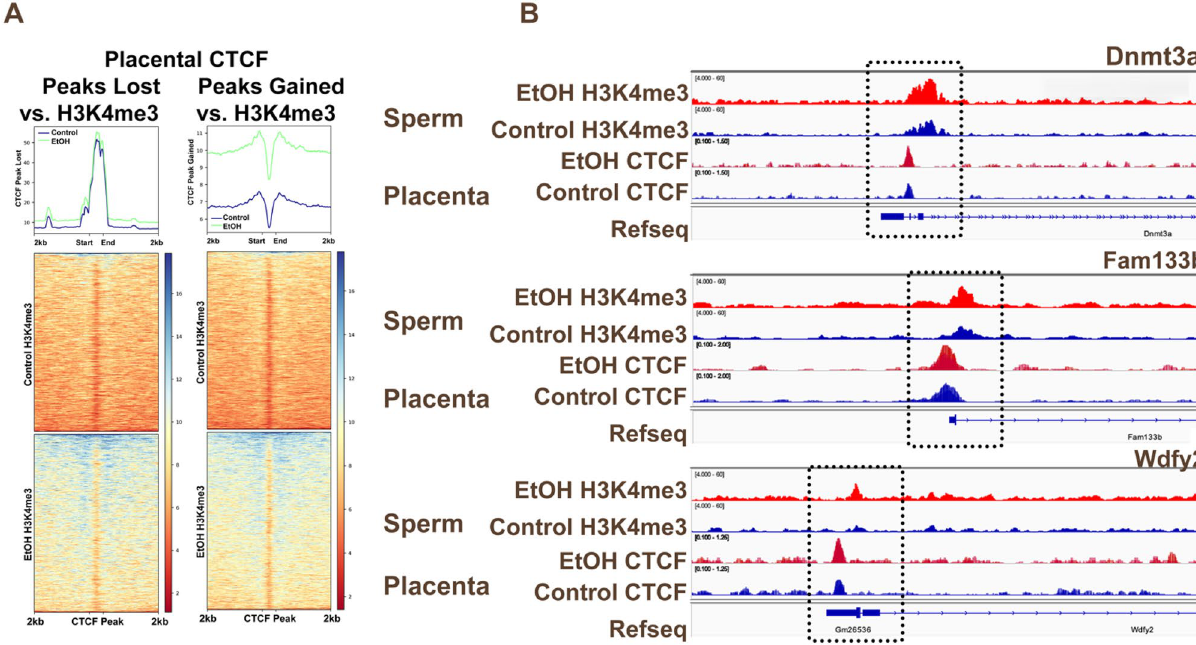
Figure 7. Correlation between EtOH-induced increases in sperm H3K4me3 enrichment and increased CTCF occupancy in male placentae sired by EtOH-exposed fathers. Heatmaps displaying H3K4me3 signals from sperm derived from control and EtOH-exposed males across ( A ) CTCF peaks lost and CTCF peaks gained in male placentae derived from the offspring of EtOH-exposed sires. ( B ) Integrative Genome Viewer tracks comparing altered H3K4me3 enrichment in alcohol-exposed sperm (top) with altered placental CTCF enrichment (bottom) across the promoter regions of Dnmt3a, Fam133b, and Wdfy2